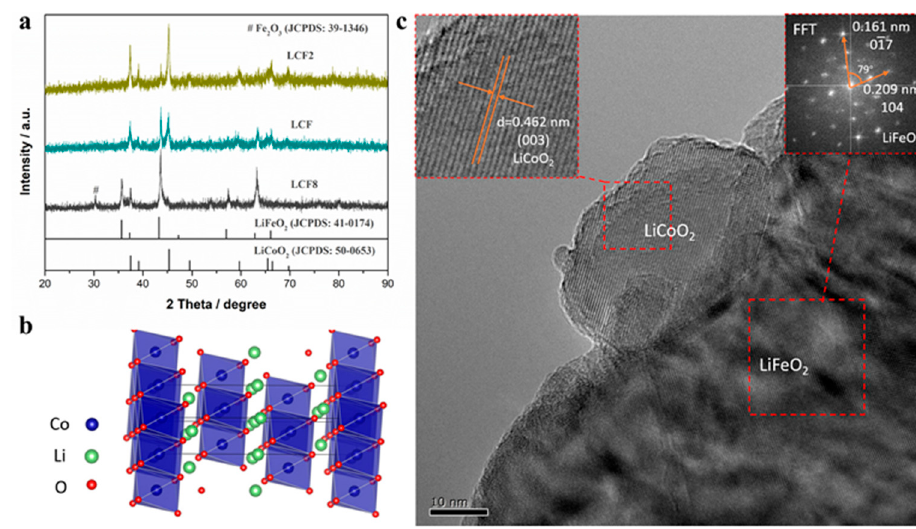
Figure 2. ( a ) XRD patterns for LCF2, LCF, and LCF8 samples synthesized via hydrothermal method. ( b ) Diagram of layer-structured LiCoO 2 . ( c ) HRTEM image of LCF nanocomposite. The enlarged image of the LiCoO 2 particle is inserted in the top left corner. Additionally, the corresponding fast Fourier transform (FFT) pattern of LiFeO 2 particle is located in the top right corner.